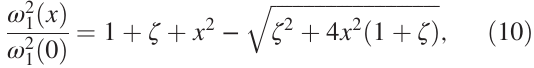
FIG. 9. Drain-bias-dependent properties of the C 1 , C 2 , C 3 , and C 4 plasma cavities. The left-hand panels show the spectra (a), (b), (c), and (d), correspondingly. The right-hand panels show the contour plots (e), (f), (g), (h), correspondingly. The dotted lines on contour plots are results of the fit with a phenomenological formula Eq. TABLE II. Properties of different plasma cavities. ffiffiffiffiffiffiffiffiffiffiffiffiffiffiffiffiffiffiffiffiffiffiffiffiffiffiffiffiffiffiffi